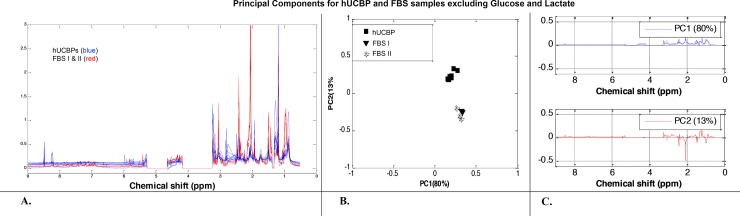
Metabolomic analysis of hUCBP and FBS samples excluding glucose and lactate spectral areas.(A) The 1H-NMR spectral trajectories; (B) the PCA score plots shows that the hUCBP samples (a well-defined cluster) and the FBS samples (also a well-defined cluster) are less divergent now (they all have a very close PC1 score) and (C) respective loading plots illustrate that the main differences between the hUCBP and FBS data are due to different concentrations of particular amino acids (alanine, glutamate, isoleucine, leucine, and valine) and organic acids and derivatives (N-acetyl residues, 3- hydroxybutyric acid, and creatine) in the spectral region from 3.3 ppm to 0.5 ppm. For spectral area between 9.0 ppm to 3.3 ppm (with excluded glucose) the metabolites profiles of the three groups (hUCBP, FBS_I and FBS_II samples) are very similar.